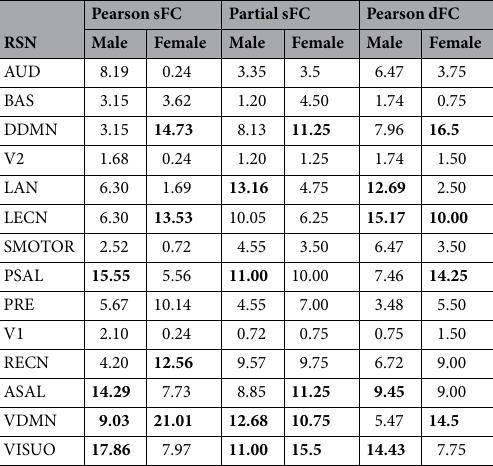
Pearson sFC Partial sFC Pearson dFC RSN